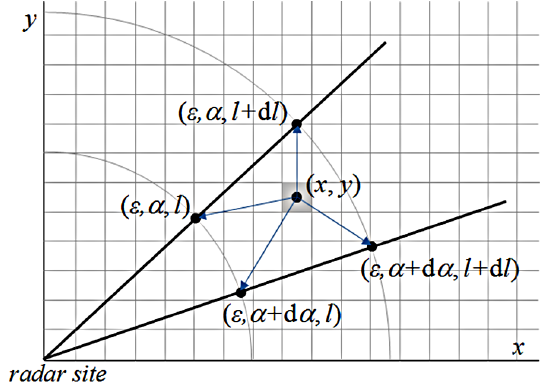
Figure 1. Scheme of interpolation of gate values into Cartesian pix-